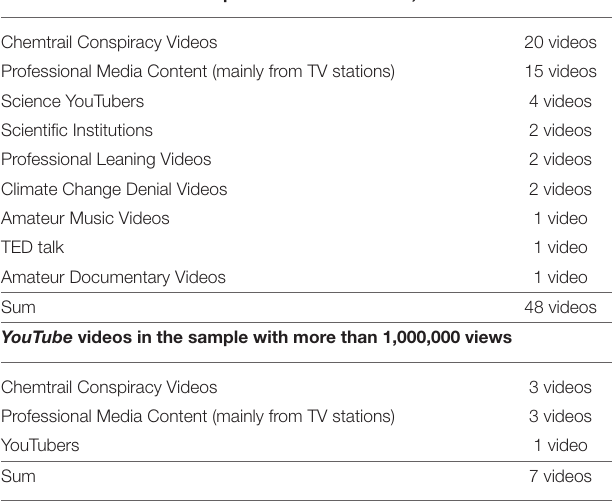
TABLE 2 | YouTube videos in the sample with more than 100,000 views/1,000,000